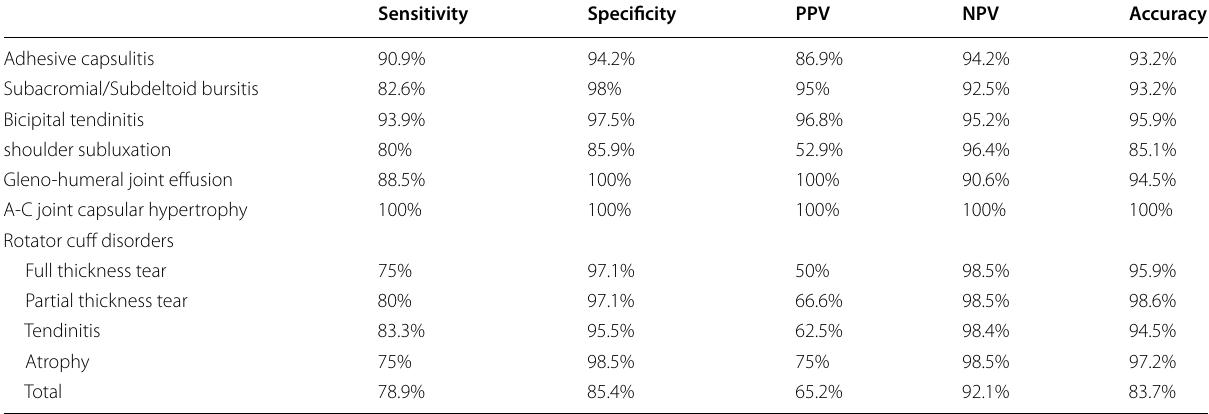
A-C acromio‑clavicular; PPV positive predictive value; NPV negative predictive value